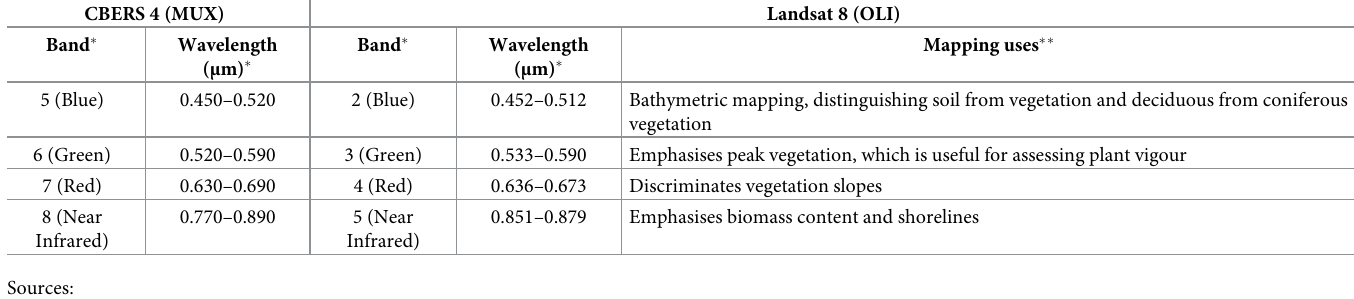
Table 4. Comparison of MUX-CBERS 4 and OLI-Landsat 8 sensor bands and their mapping utilities. CBERS 4 (MUX) Landsat 8